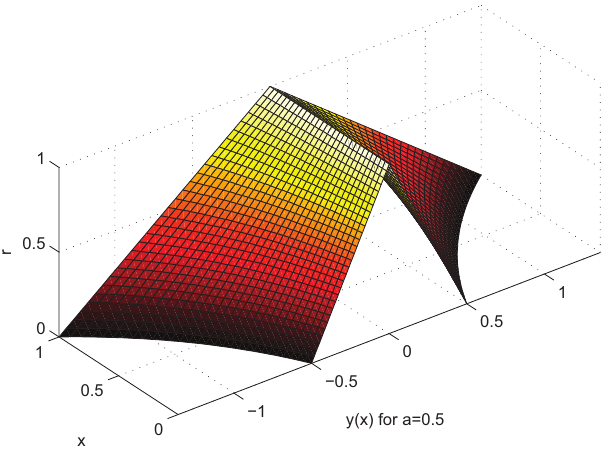
Figure 2. The solution of fuzzy differential equations (FDE) under case 1 consideration.